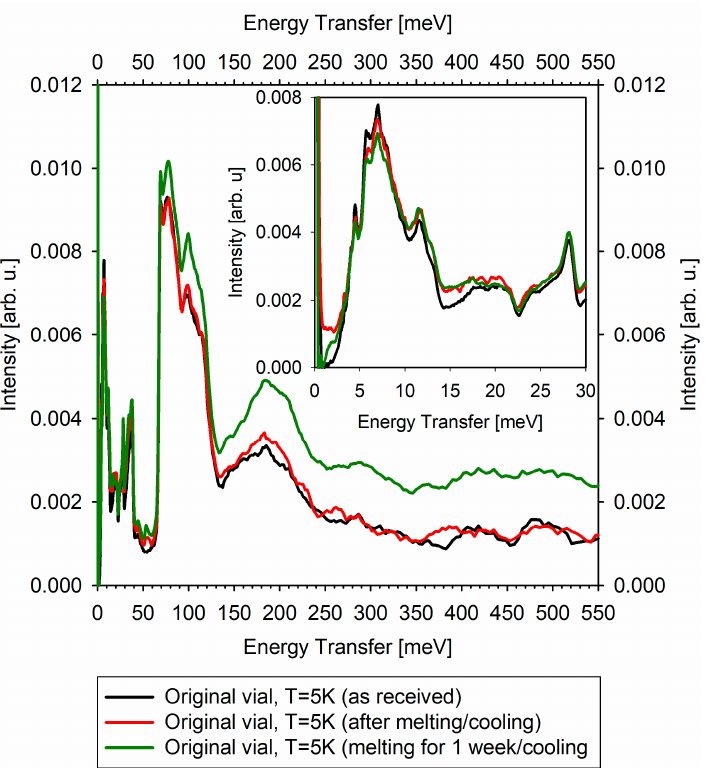
Figure 3. INS spectra measured at the VISION neutron spectrometer (the elastic peak maxima are normalized to unity). The inset shows zoomed ‐ in spectra to emphasize the difference in the signal at low energy transfer, particularly, 0–3 meV.